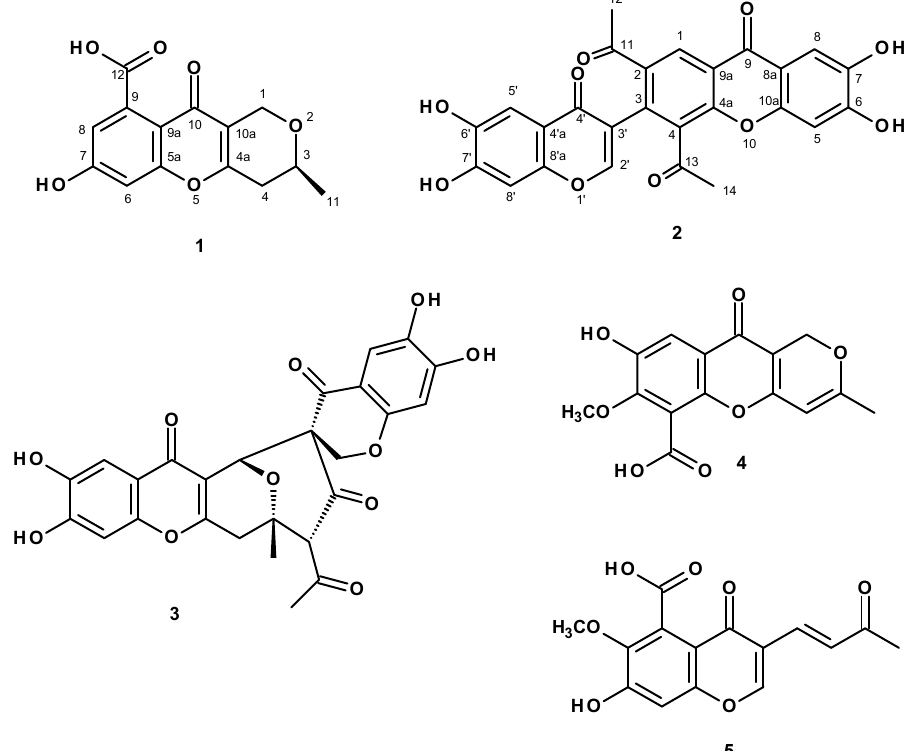
Figure 1. Structures of erubescensoic acid ( 1 ), SPF-3059-26 ( 2 ), erubescenschromone B ( 3 ), penialidin D ( 4 ), and 7-hydroxy-6-methoxy-4-oxo-3-[(1 E )-3-oxobut-1-en-1-yl]-4 H -chromen-5-carboxylic acid ( 5 ).